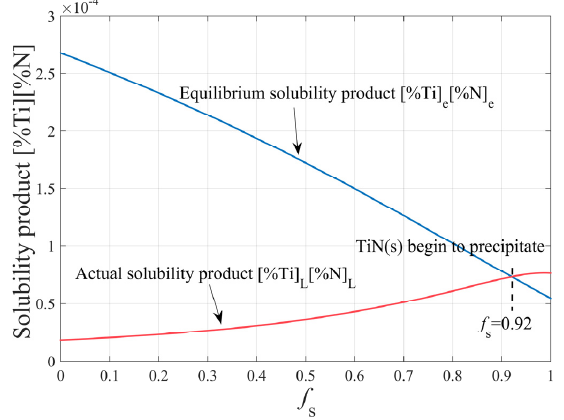
Figure 5. The thermodynamic conditions of TiN precipitation during solidification.